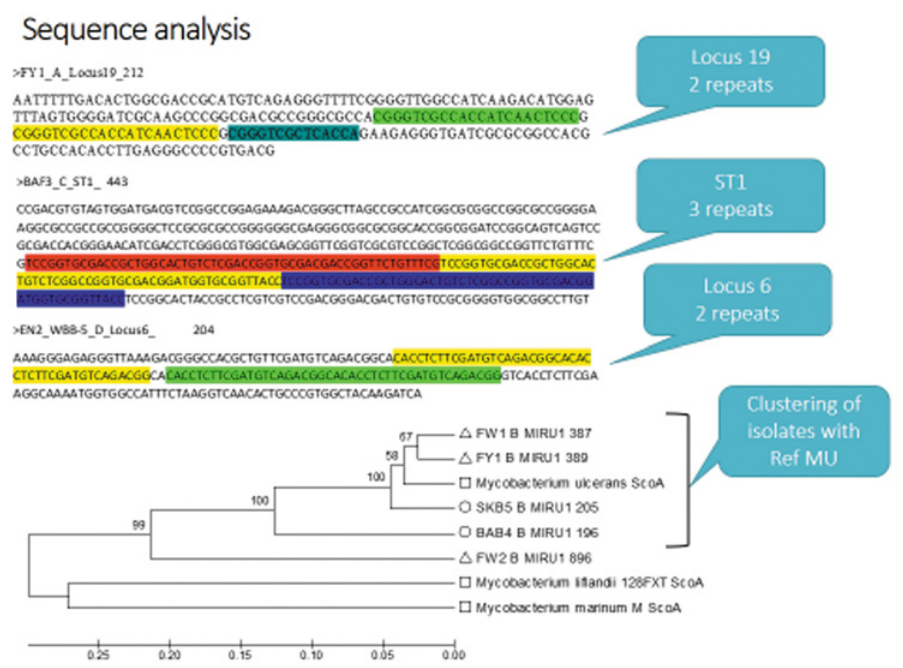
Figure 2. Sequence confirmation of VNTR repeats and phylogeny of MU isolates. The evolutionary history was inferred using the UPGMA method [39]. The optimal tree with the sum of branch length = 1.31639434. The percentage of replicate trees in which the associated taxa clustered together in the bootstrap test (1000 replicates) are shown next to the branches [40]. The reference sequences (represented with square) of the MIRU1 (ScoA gene) orthologs, M. marinum , M. liflandii and M. ulcerans were retrieved from GenBank with accession numbers CP000854.1, CP003899.1 and DQ397533.1 respectively. Sequences of human and environmental samples are represented with triangles and circles respectively. Tandem repeats were analysed using Tandem Repeat Finder [41] and pattern searches in Microsoft Word